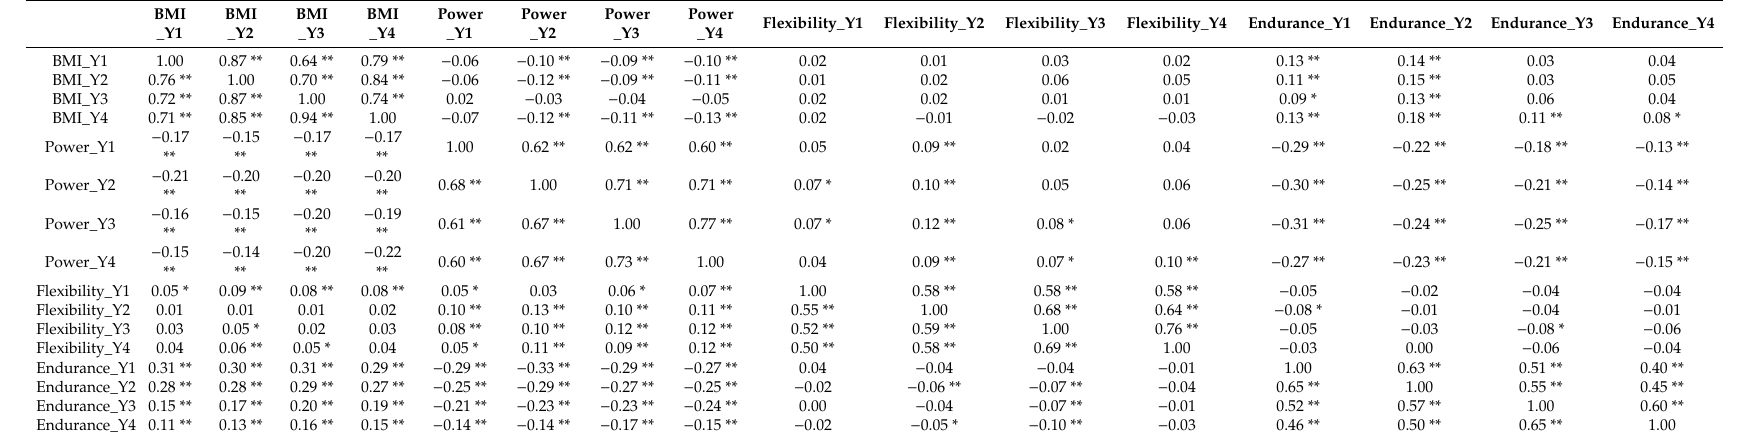
Table 3. Coe ffi cients of BMI, flexibility, explosive power, and cardiorespiratory endurance with normal / overweight / obese weight